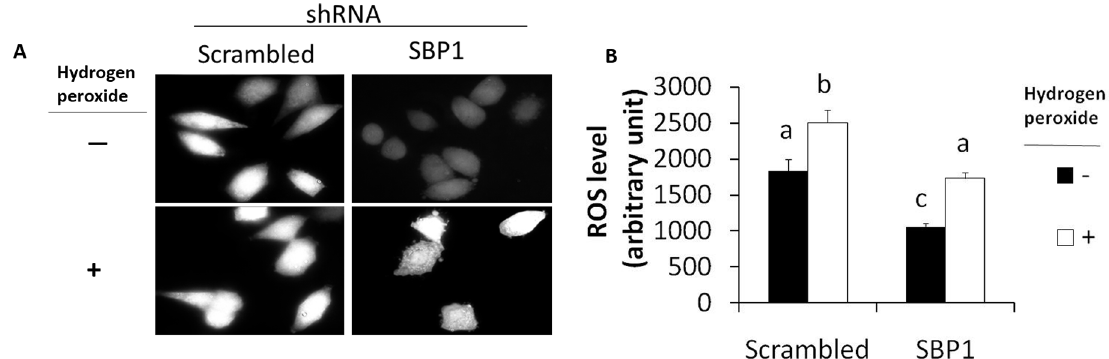
Fig 2. Knockdown of SBP1 decreases ROS levels in HeLa cells before and after treatment with hydrogen peroxide. Scrambled and SBP1 shRNA HeLa cells were cultured in the presence or absence of hydrogen peroxide (100 μ M, 3 h), followed by incubation with CM-H2DCFDA (5 μ M, 15 min, 37°C) and acquisition of FITC signal through a fluorescence microscope. (A) Representative pictures as observed under a fluorescence microscope. (B) FITC signals were quantitated using the intensity tool of the Zeiss AxioObserver 100 software. Values are means ± SEM (n = 3) and differ when not sharing a common letter (p < 0.05).